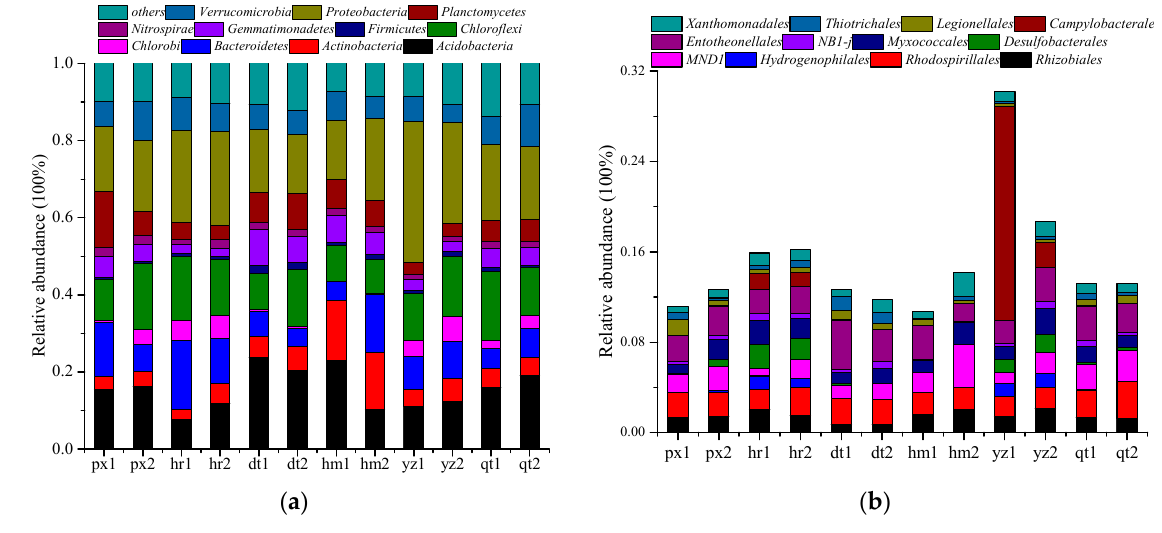
Figure 5. Taxonomic distributions of 12 soil samples. ( a ) Phylum profile; ( b ) Order distribution of phylum Proteobacteria.